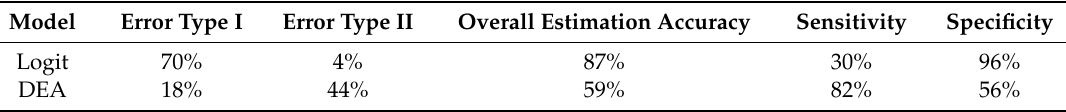
Table 7. Comparison of the estimation accuracy of the ADD and Logit models corresponding to optimal cut-off for the DEA model.